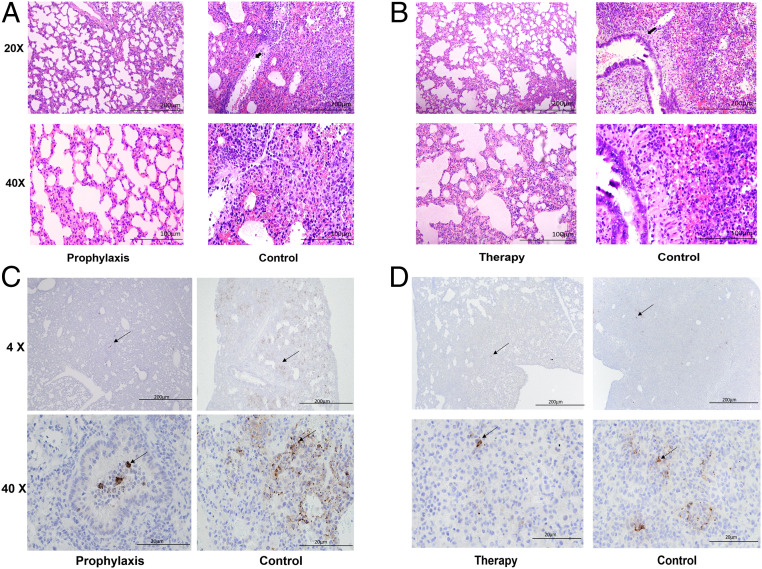
Histopathology (H&E) and IHC of hamster lung tissue. (A and B) Treatment with IgG1 ab1 reduces pathological changes in lung tissue. H&E-stained sections of lungs were compared between untreated hamsters (control), IgG1 ab1 prophylactically treated hamsters (A), and therapeutically treated hamsters (B). Images represent pathological changes in lung tissues. Arrows show the inflammatory cell infiltration with alveolar hemorrhage. (C and D) IHC for detection of SARS-CoV2 nucleocapsid antigen with anti-nucleocapsid rabbit polyclonal antibodies followed by the horseradish peroxidase (HRP)-conjugated anti-rabbit antibody. A granular, multifocal distribution is noted in lung tissue background from control animals while prophylactic treatment with IgG1 ab1 resulted in a marked reduction in the distribution of antigen-positive cells. Arrow indicates nucleocapsid-positive cells (brown) in lungs at day 5 postinfection. (D) The lung IHC for IgG1 ab1 therapeutically treated hamsters compared to those of controls.